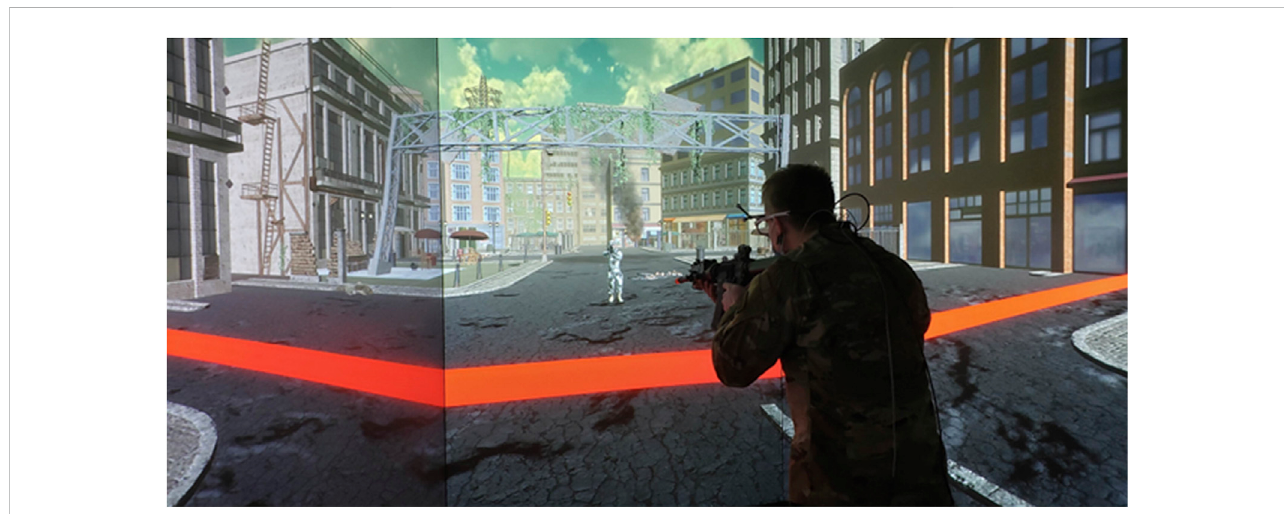
FIGURE 5 An example DMT trial, with a potential target approaching the participant. The participant has raised their weapon, usually in preparation to fi re upon the